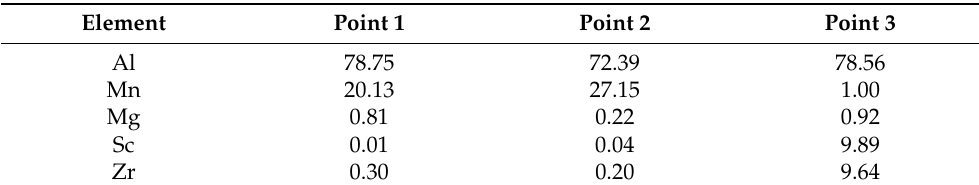
Table 5. EDS analysis of the second phases around grain boundaries shown in Figure 9d. (wt.%).